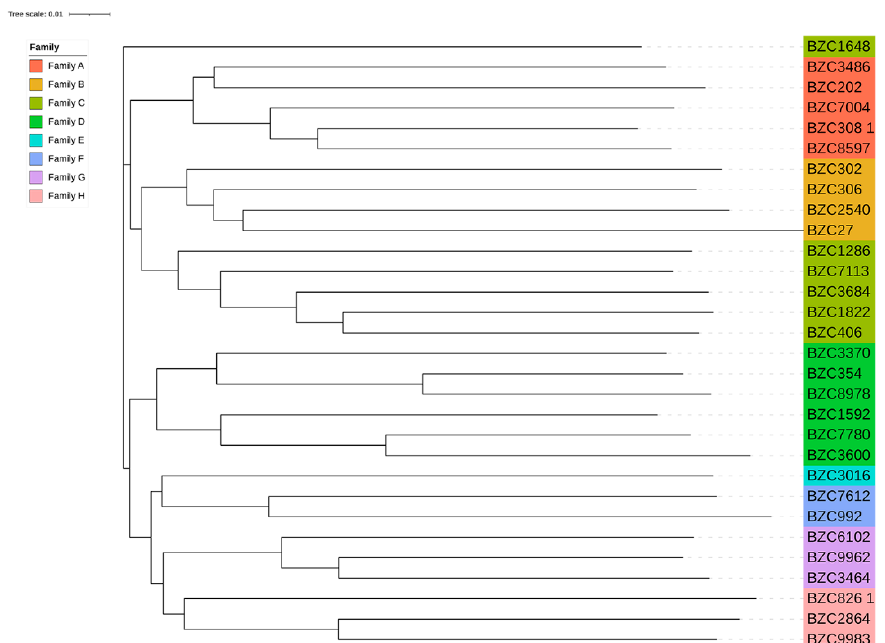
Figure 2. Phylogenetic tree of boars in this population. Individuals with the same color belong to the same familial lineage.